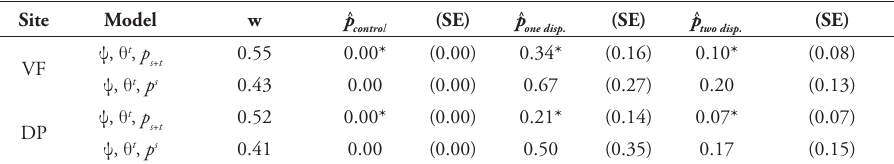
Table 4. Detection probabilities estimates by monitoring during 2014. O. eremita detection probability estimates ( p ^ ) and associated standard errors (in parenthesis) are given for the plausible candidate models (ΔAIC < 2) (w = Akaike’s weight for each model), during 2014 in PA (PA = Parco Nazionale d’Abruzzo Lazio e Molise; VF = Val Fondillo; DP = Difesa di Pescasseroli).